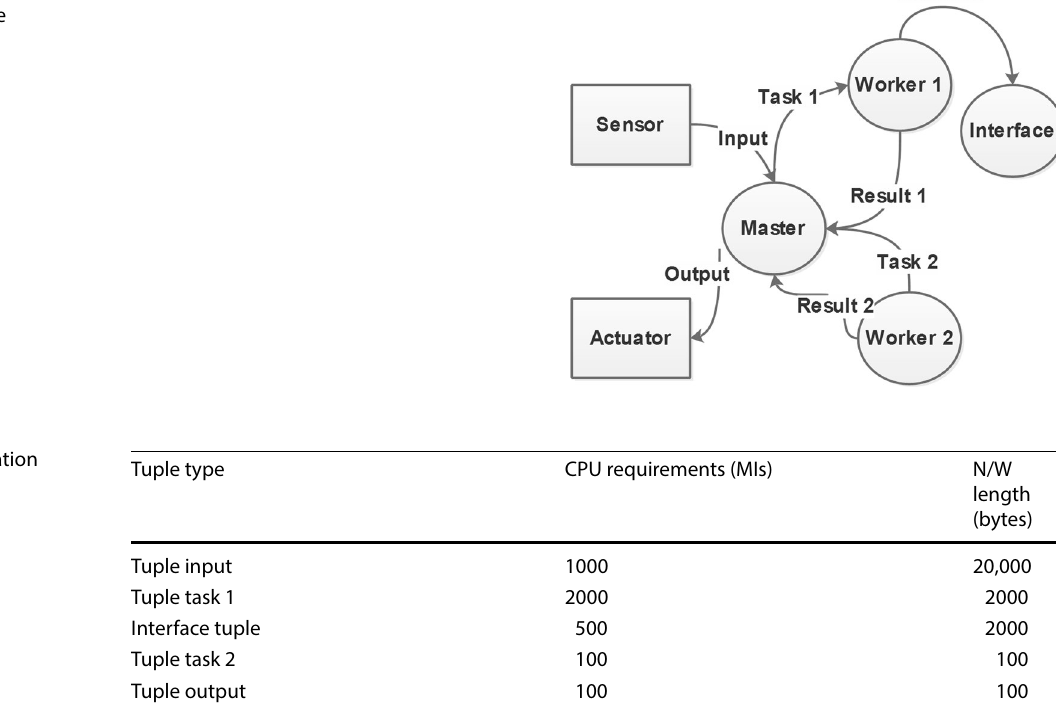
Fig. 3 The Master-Worker application module